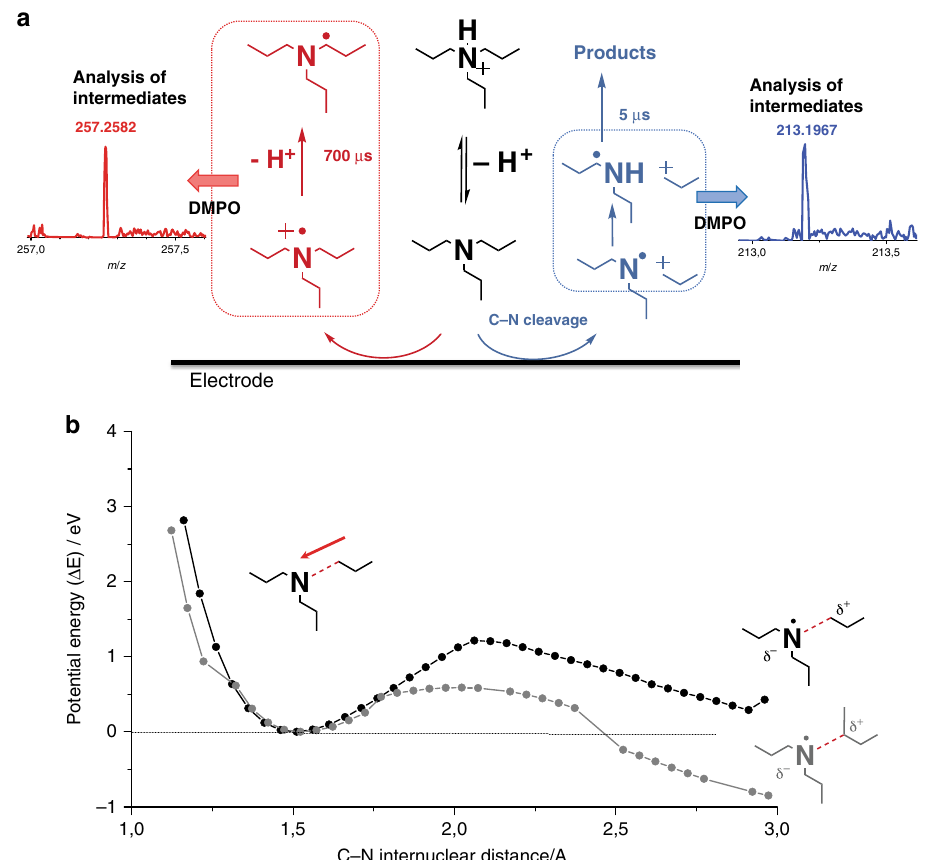
Fig. 3 Proposed mechanism for tri-n-propylamine (TPrA) and dipropylamine (DPrA) radical generation. a Schematic representation of the proposed parallel pathways for the tri- n -propylamine (TPrA) oxidation at the electrode where TPrA radical cation and radical are generated (red pathway) and where dipropylamine radical (DPrA) is generated (blue pathway). The scheme reaction is supported by spin-trapping experiments with 5,5-dimethyl-pyrroline N - oxide (DMPO), which stabilized the radicals and allowed identi fi cation by mass spectrometry analysis (MS) and electron paramagnetic resonance (EPR). The inset in a shows the MS analysis for the possible adducts DMPO-TPrA and DMPO-DPrA (see “ Supplementary Methods 3 ” for the detailed mechanism and Supplementary Fig. 12 and Supplementary Tables 2 and 3). b Potential energy curve along C – N (dashed red bond in the depicted molecular structures) stretching of TPrA (black curve and dots) and DPIBA (gray curve and dots) computed with UM062X/6-31G* in H 2 O (described with IEFPCM method at each point of the curve, the energy of the equilibrium structure has been subtracted). The calculations are run in the presence of an external electric fi eld (~10 8 V cm − 1 ) whose orientation is represented by the red arrow. Under the effect of the external electric fi eld the curves acquire a typical reaction pro fi le. The mechanism shows a prevailing ionic character with the formation of a carbocation propyl fragment (represented by the δ + charge on the molecular